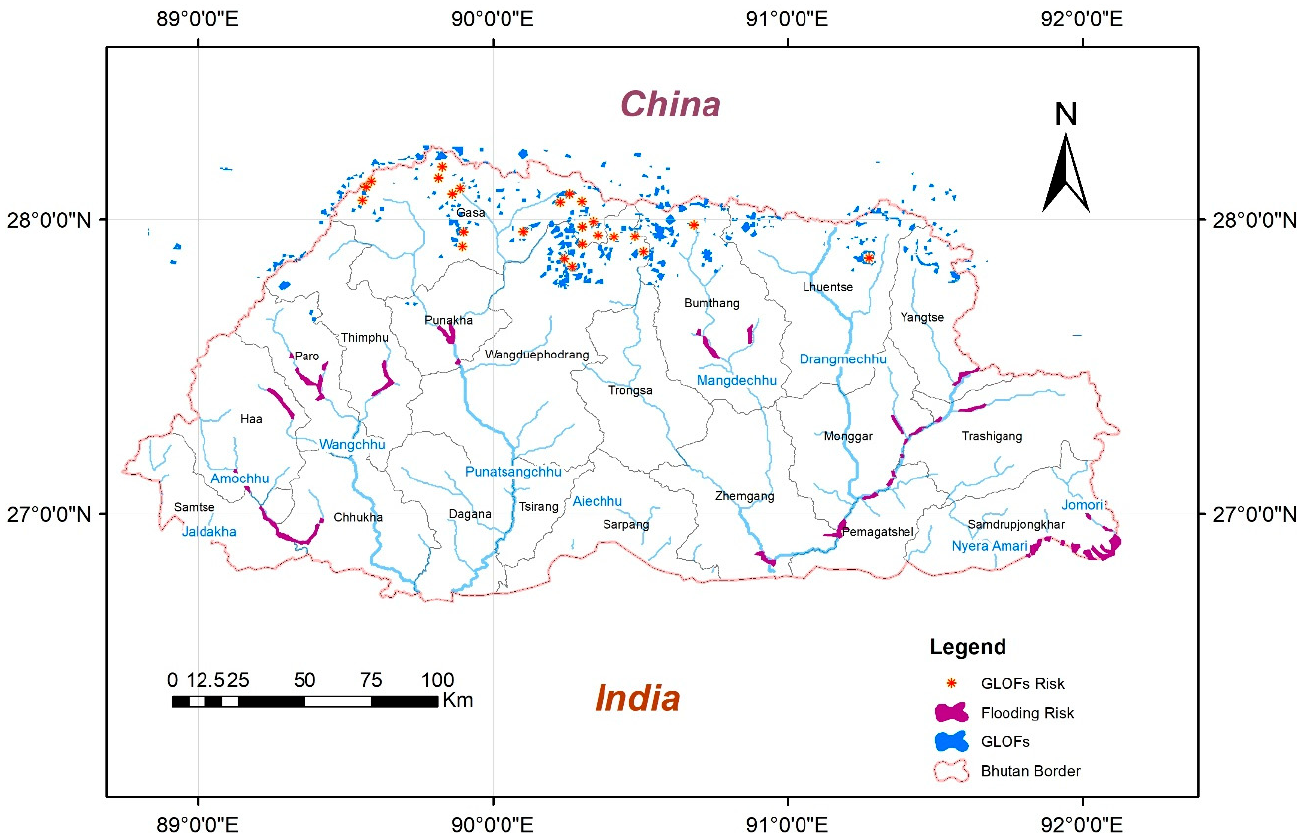
Figure 6. Map showing areas prone to flooding and potential glacial lake outburst flood (GLOF) lakes (Data source: National Environment Commission, Meenawat and Sovacool [7,48]).